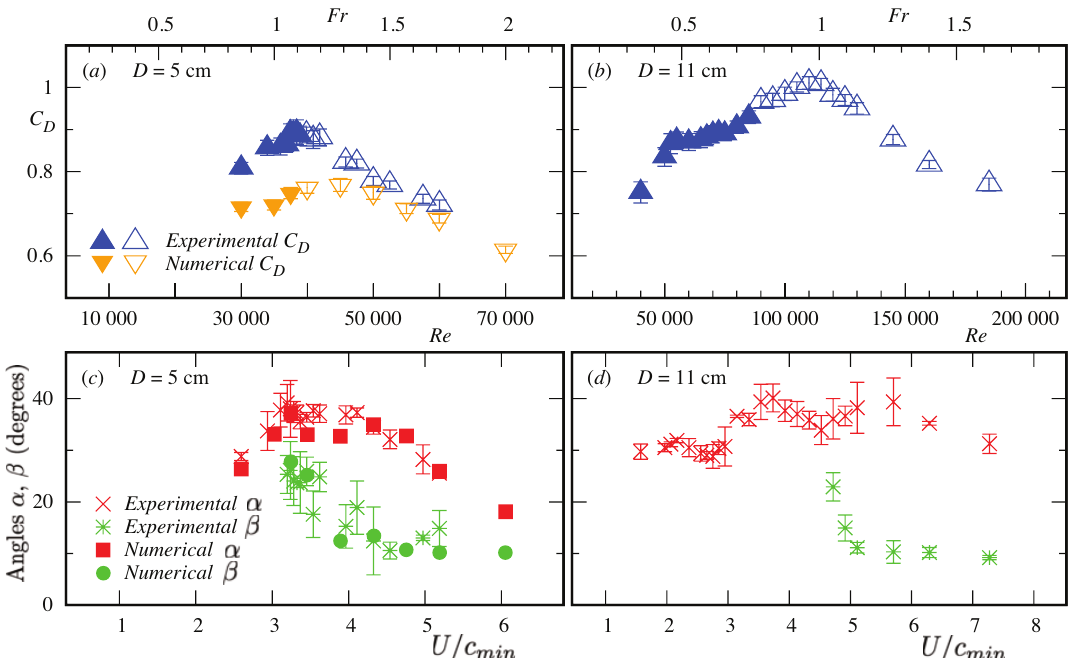
Figure 6. Drag coefficients, C D , and wave half-angles, α and β , as a function of Re , Fr and U / c min for cylinders of diameter D = 5 and 11 cm. ( a ) C D from experiments and simulations for D = 5 cm. ( b ) C D for D = 11 cm. The filled symbols represent cases without air entrainment and the open symbols are for cases with air entrainment. ( c , d ) are the wake half-angles, α and β (defined in Figure 6c,d) for D = 5 and 11 cm,